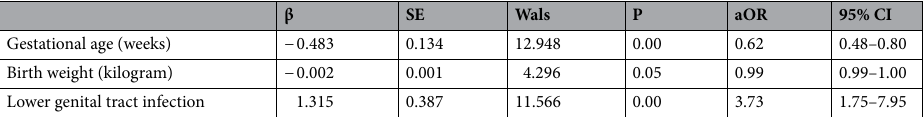
Table 4. Correlative factors for PV–IVH Deterioration in Preterm infant. Adjusted for: gestational age, birth weight, lower genital tract infection. PV–IVH periventricular–intraventricular hemorrhage, aOR adjusted odds ratio, 95% CI 95% confidence